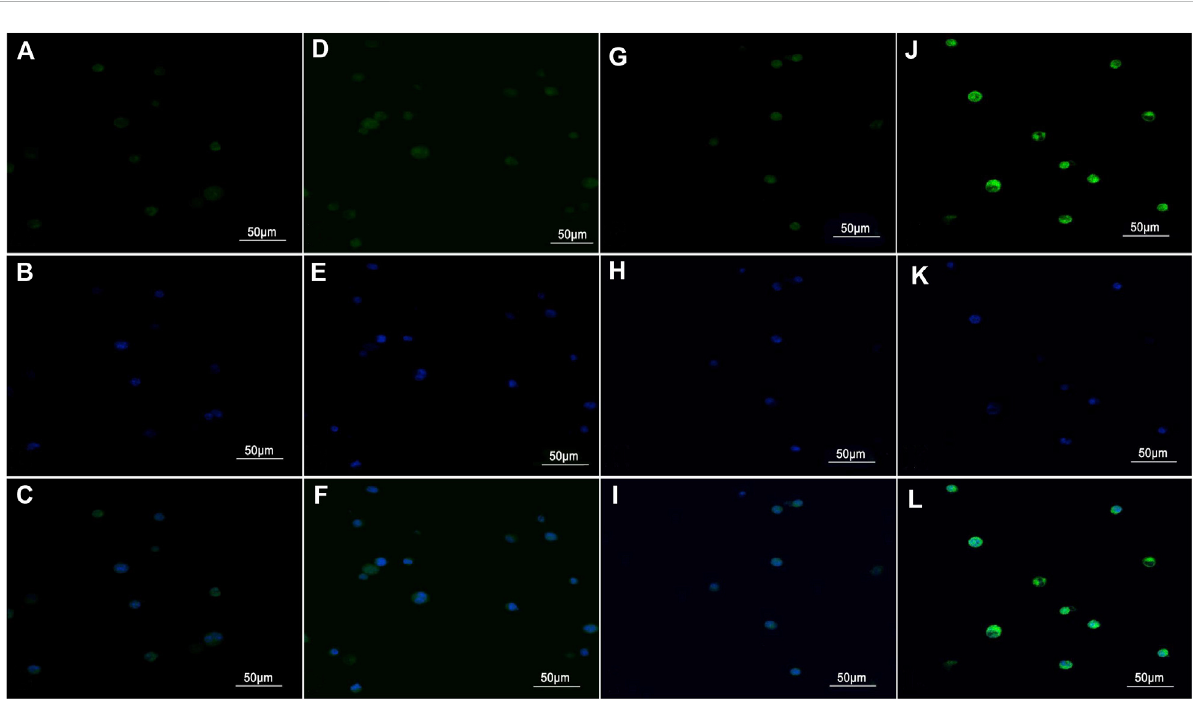
FIGURE 2 Imageswereacquiredusingalaserconfocalscanningmicroscope(×400). (A,D,G,andJ) Green fl uorescencewasobservedinthecytoplasmof cellsaftertheuptakeofthecontrastmedium. (B,E,H,andK) Blue fl uorescencewasobservedinDAPI-stainednuclei. (C,F,I,andL) Thecytoplasmand thenucleus weremerged. (A – C) Hca-F cells with PLGA NPs. (D – F) Hca-F cells with antibody blocking. (G – I) Hca-P cells with GSN-PLGA NPs. (J – L) Hca-F cells with GSN-PLGA